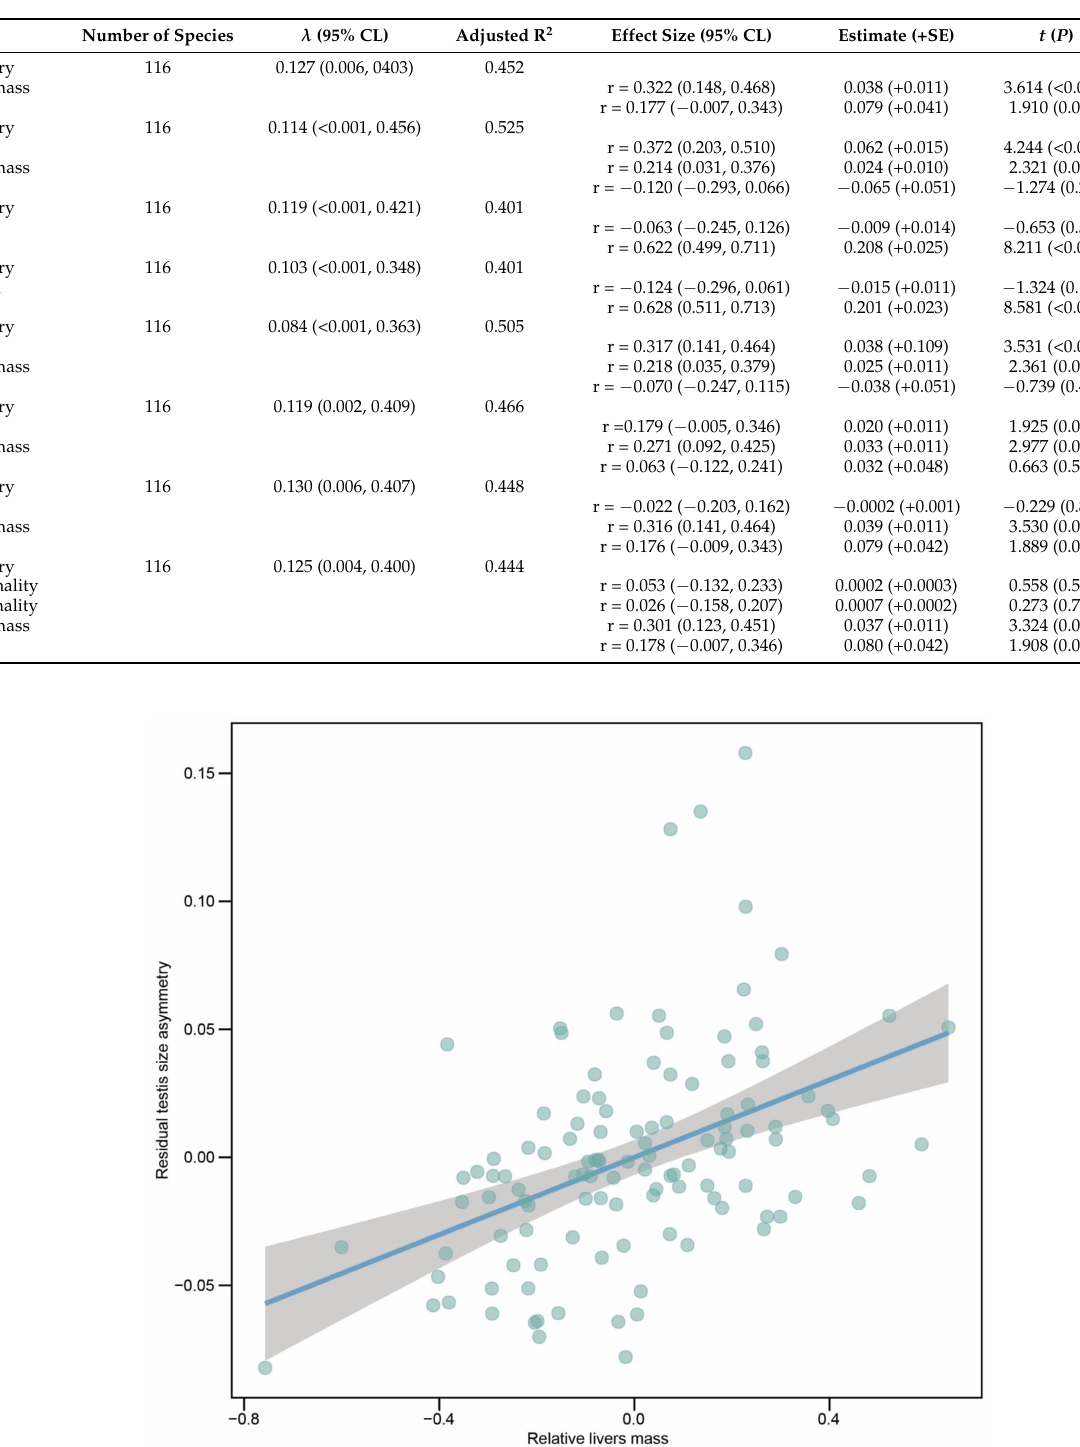
Table 1. Models predict testis size asymmetry when controlling for phylogeny effect using the PGLS function in the R package caper [44]. Lambda ( λ ) estimates the phylogenetic signal using maximum likelihood. Effect sizes were calculated following Nakagawa and Cuthill [49]. Effect sizes and their non-central 95% CLs were calculated as partial r for continuous predictors. For each model estimates of the coefficients for each effect are listed, and significance levels tested with the t -statistic.